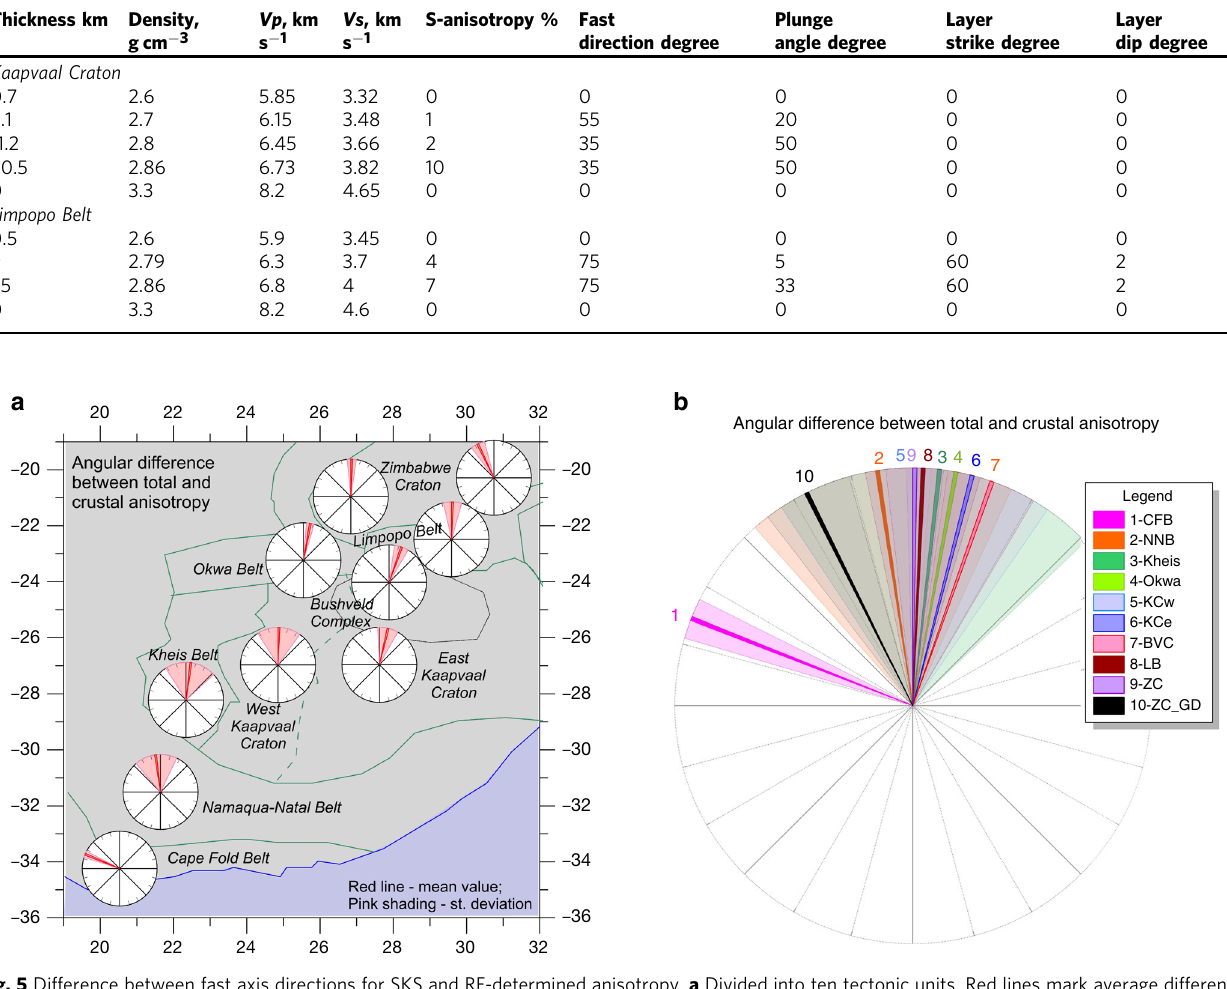
Fig. 5 Difference between fast axis directions for SKS and RF-determined anisotropy. a Divided into ten tectonic units. Red lines mark average difference, and pink shading marks standard deviation in the rose diagrams, where zero difference corresponds to the north direction. b All differences plotted in the same rose diagram. The SKS- and RF directions are generally parallel, except for the Cape Fold Belt and to some degree the northern part of the Zimbabwe Craton around the Great Dyke. Abbreviations : CFB — Cape Fold Belt, NNB — Namaqua – Natal Belt, KB — Kheis Belt, OB — Okwa Belt, KCw — West